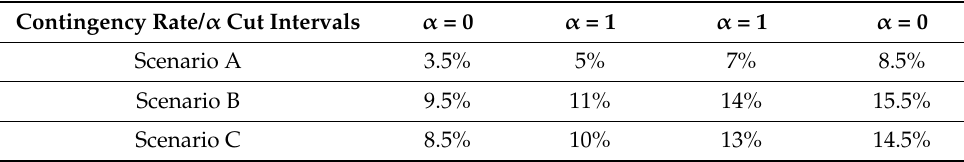
Table 7. Contingency rate considered with fuzzy sets.